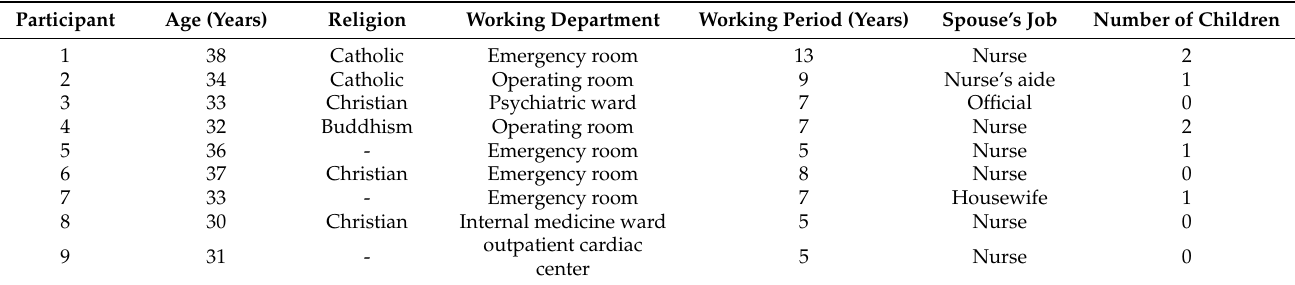
Table 1. Participants’ demographic characteristics.